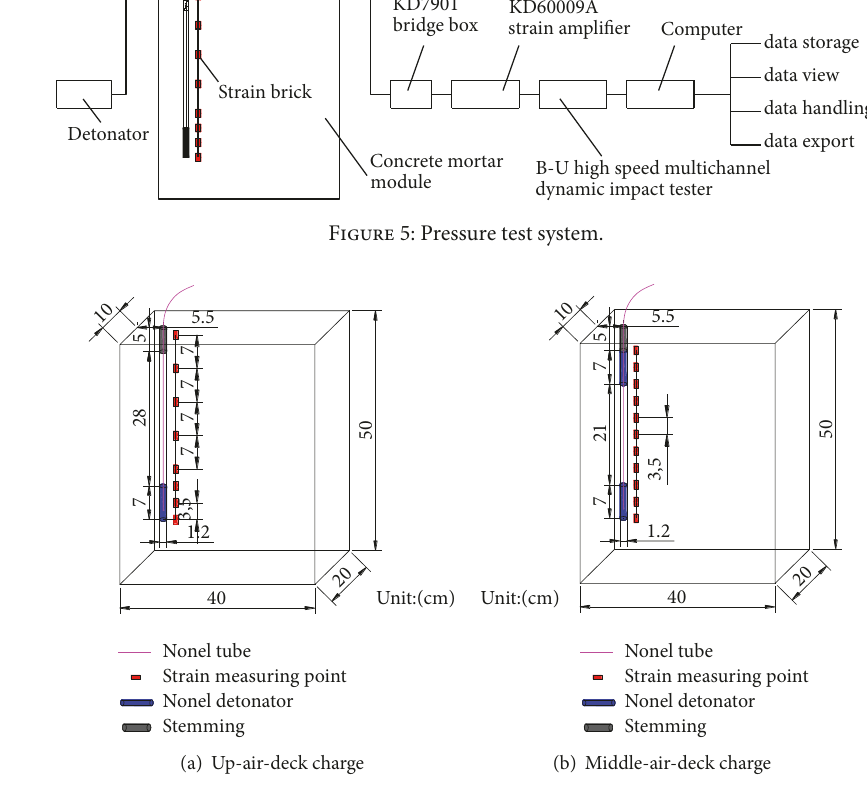
Figure 6: The cement mortar model and layout of measuring points. Table 2: Physical-mechanical parameters of the